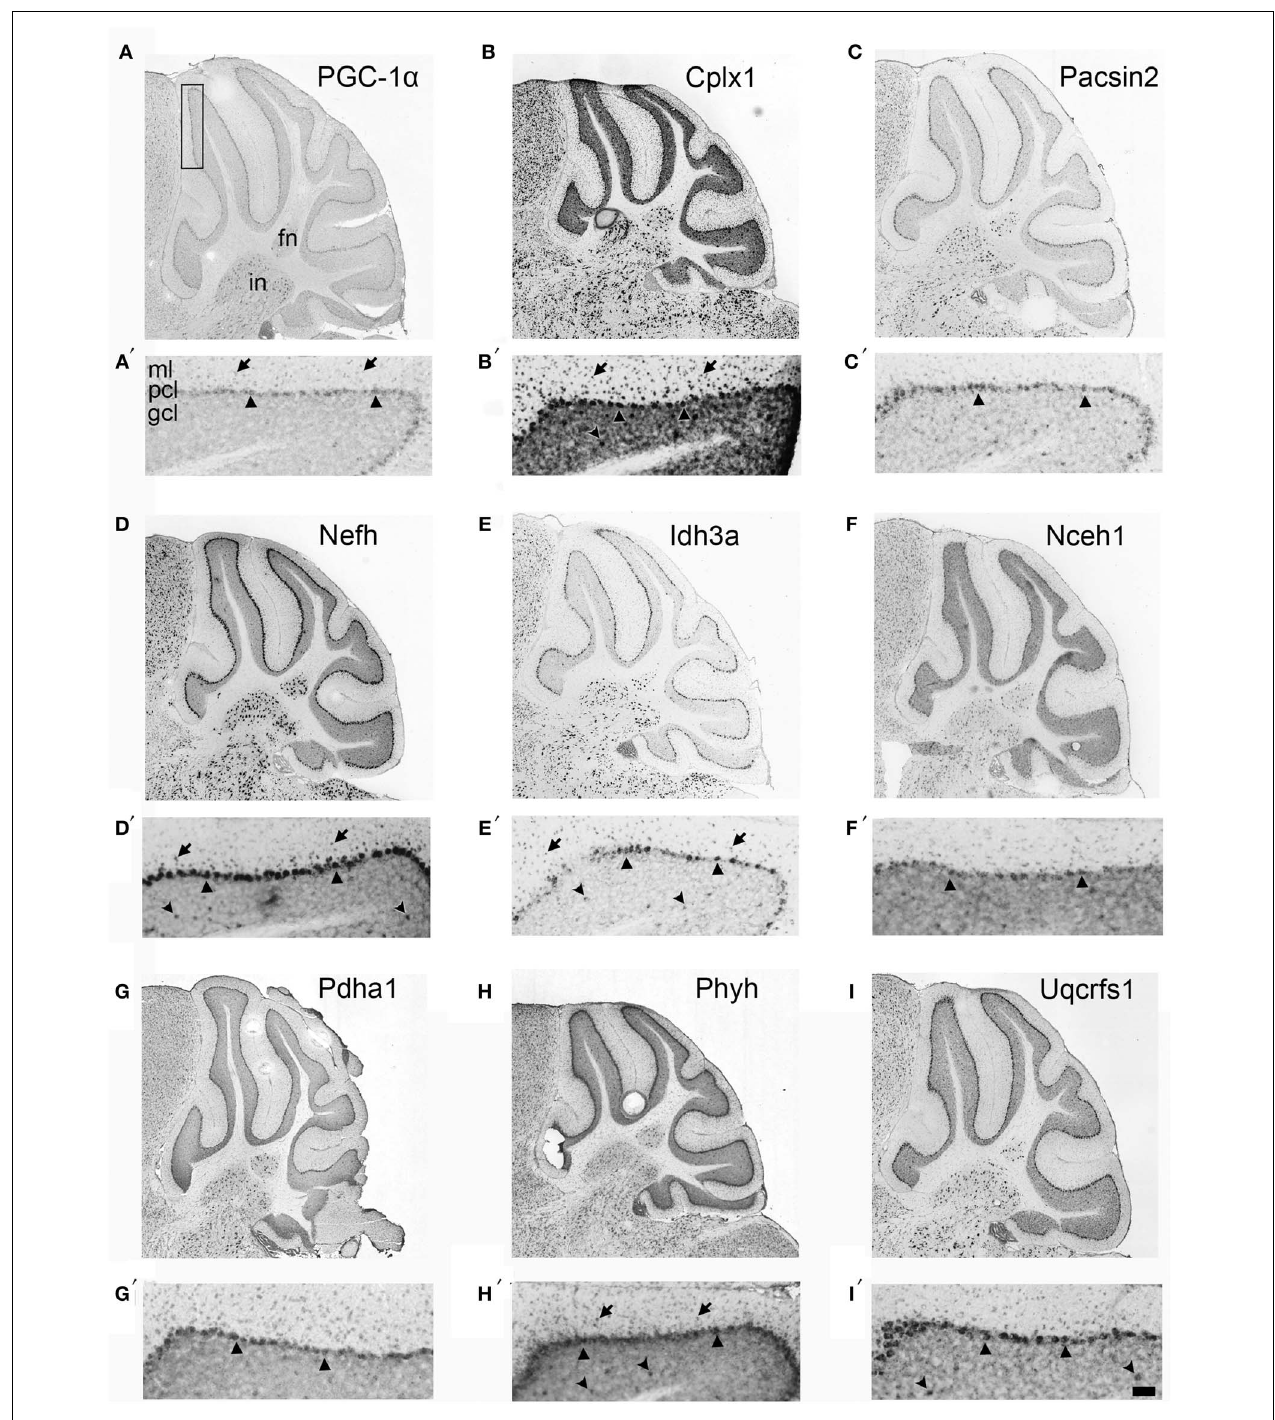
arrowheads) and the fastigial (FN) and interposed (IN) deep cerebellar nuclei. Most transcripts also exhibited expression in the molecular layer (ML; arrows), and Cplx1, Nefh, Phyh mRNA exhibited expression in the granule cell layer (GCL; concave arrowheads). Boxed portion in A represents area of higher magnification images in A (cid:4) –I (cid:4) . Scale bar = 525 μ m for A–I and 100 μ m for A (cid:4) –F (cid:4)